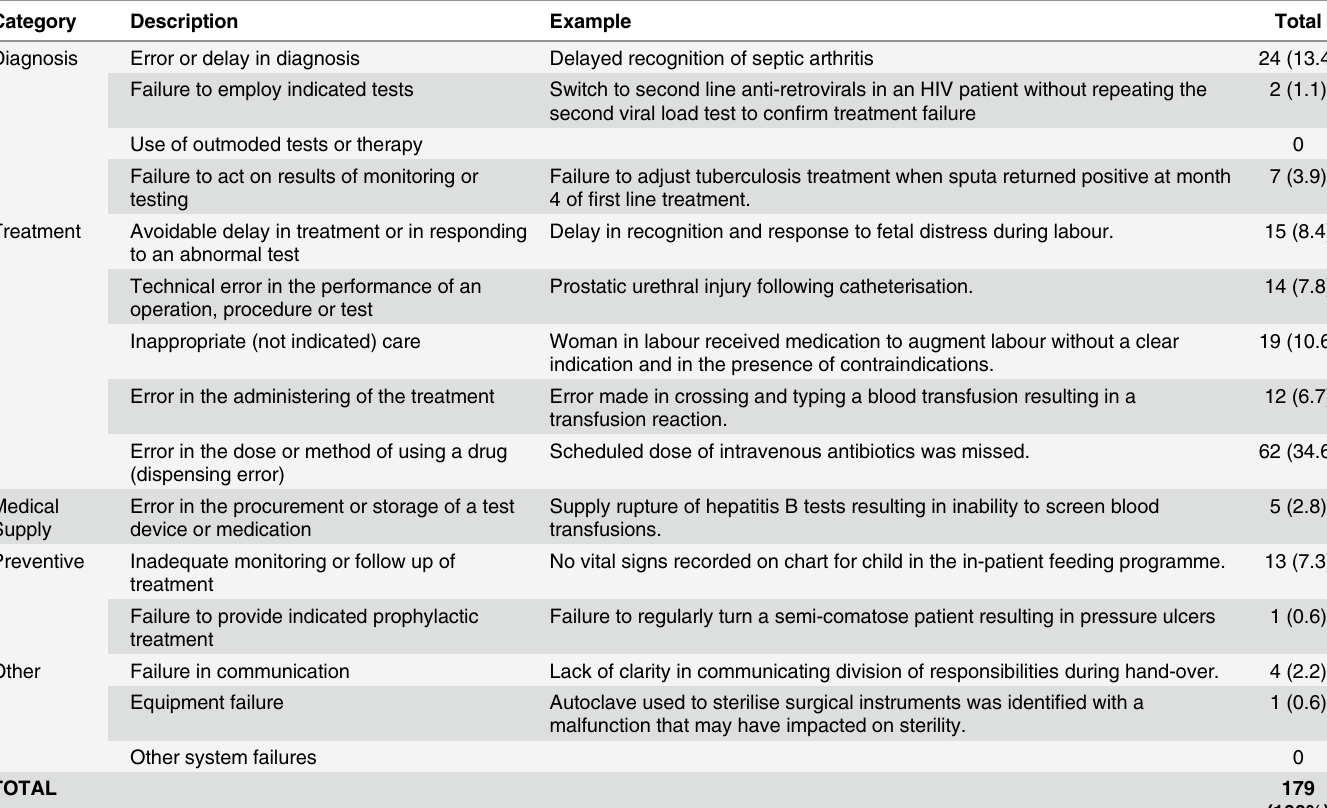
Table 2. Types of Errors